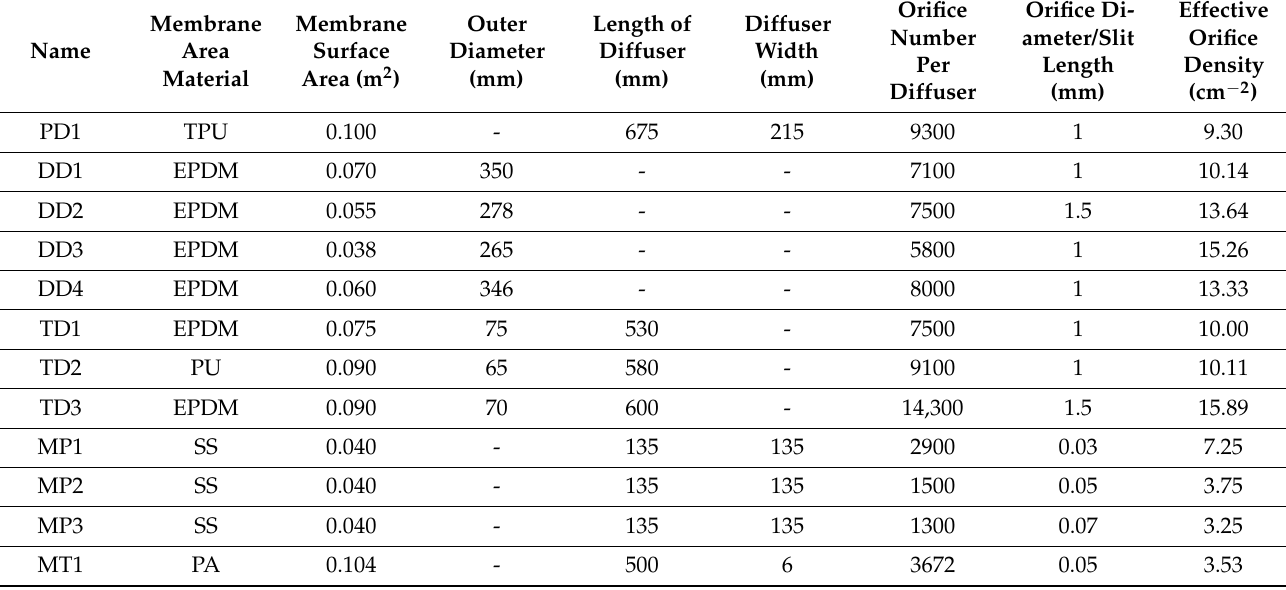
Diffuser type: DD1 to DD4 disc diffusers; TD1 to TD3 tube diffusers; PD1 plate diffusers; MP1 to MP3 micro-perforated plate diffusers; MT micro-perforated tube diffuser; A: perforated diffuser area; EPDM = ethylene propylene diene mono- mer rubber; PU = polyurethane; TPU = thermoplastic polyurethane; SS = stainless steel; PA = polyamide.